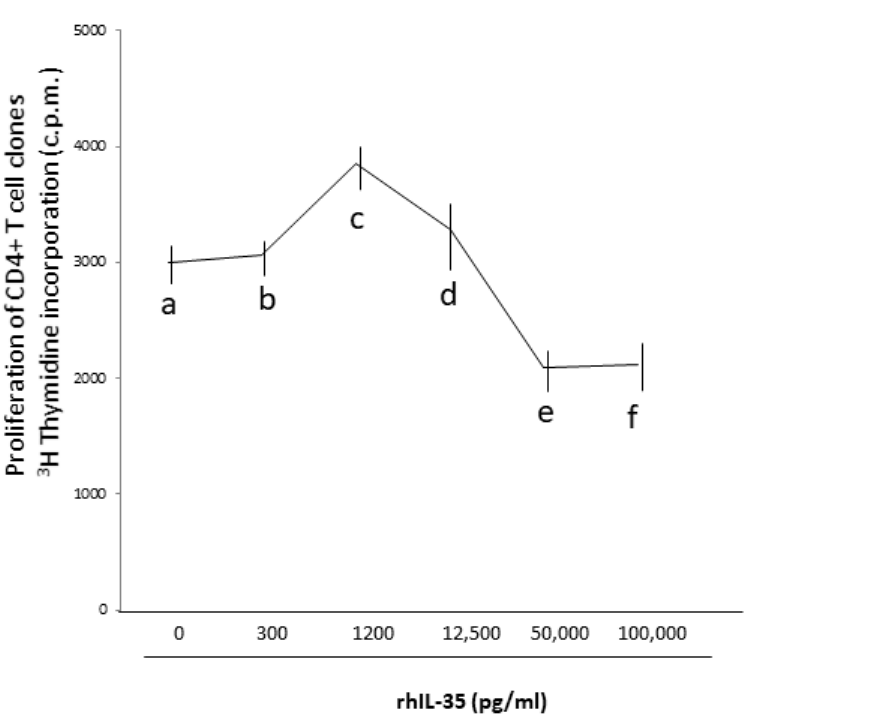
Figure 6. RhIL-35, at low concentrations compatible with those produced by human primary trophoblasts, does not inhibit the CD4+ T-cell clone proliferation, but at high concentrations it inhibits T-cell clone proliferation. Nine additional CD4+ T-cell clones generated from the peripheral blood of healthy subjects were stimulated with immobilized anti-CD3 mAb in the absence and in the presence of different concentrations of rhIL-35 (range 100 pg/mL- 100 ng/mL), and the proliferative activity of these T-cell clones was evaluated by 3 H thymidine incorporation (c.p.m.).